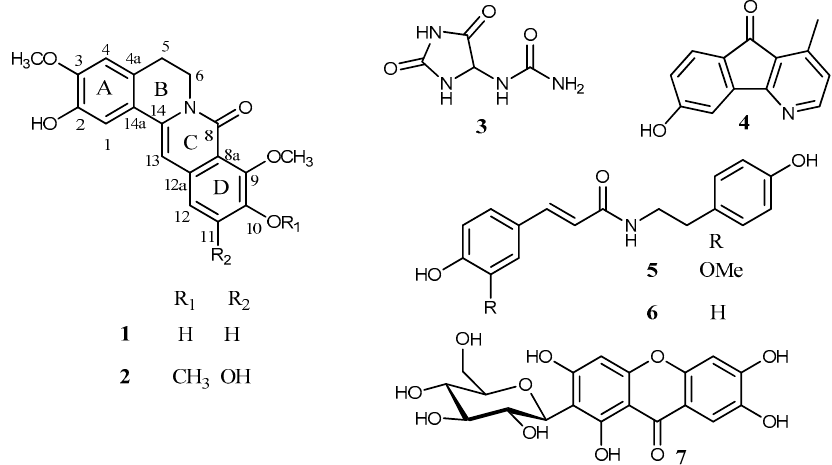
Figure 1. Chemical structures of compounds 1 – 7 isolated from Huberantha jenkinsii .